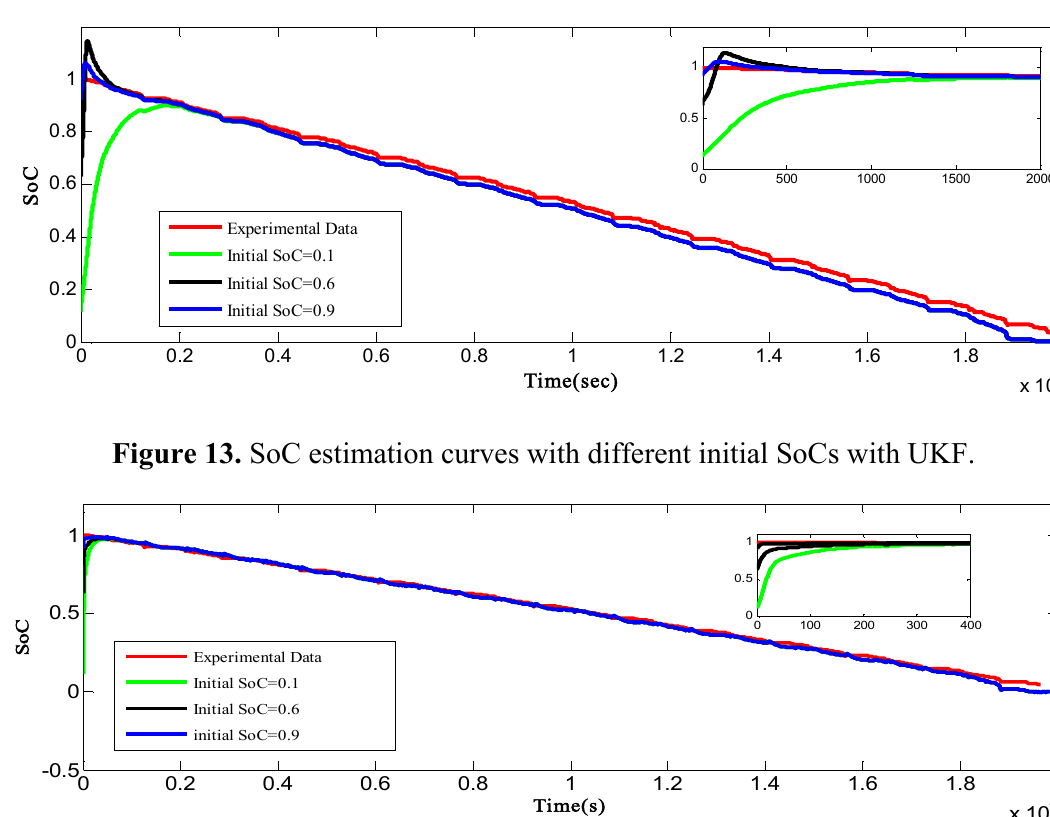
Figure 12. SoC estimation curves with different initial SoCs with EKF.